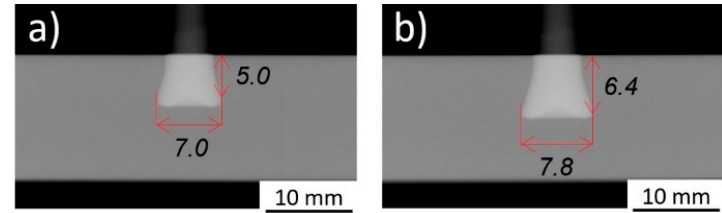
Figure 9. X-ray tomography of: ( a ) Condition 6 (RS = 20,000 rpm; FT = 1.6 s; FoT = 2 s; FF = 2000 N; FoF = 5100 N); ( b ) Condition 7 (RS = 18,000 rpm; FT = 2 s; FoT = 2 s; FF = 2000 N; FoF = 5100 N).